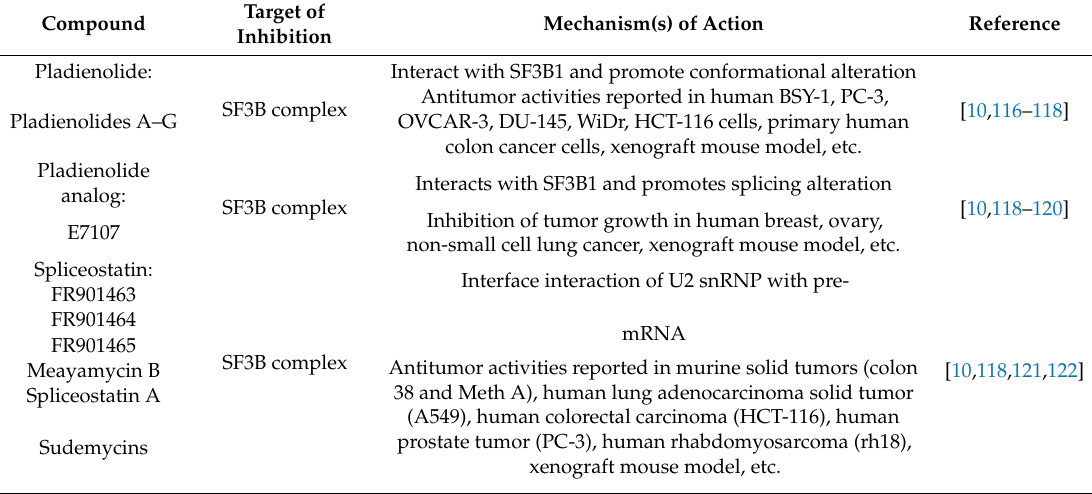
Table 2. Small molecule splicing modulators in